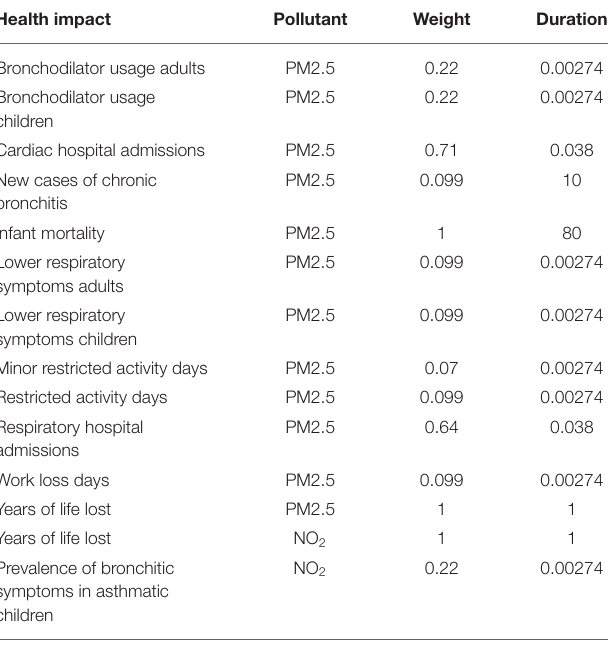
TABLE 3 | DALY weights and durations.